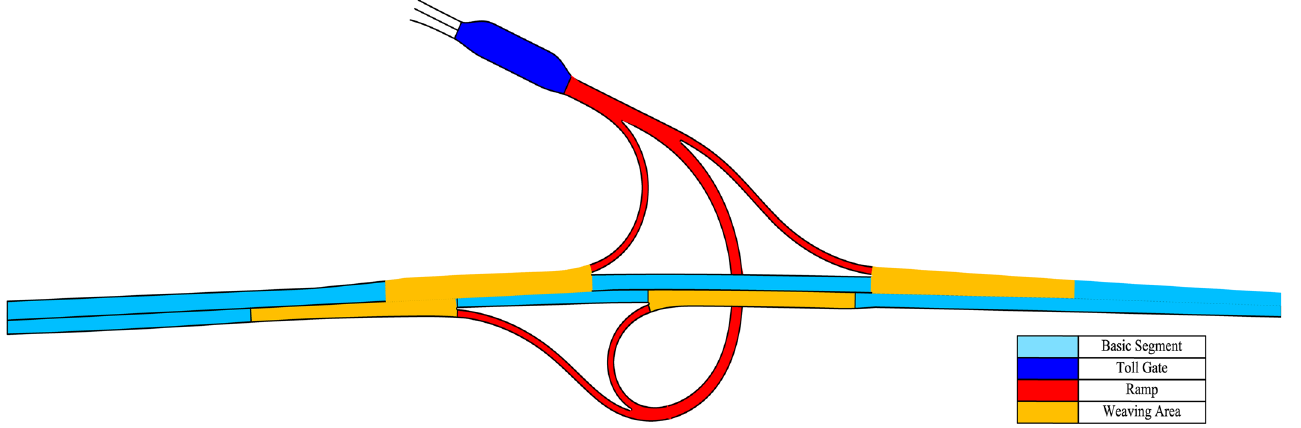
Fig 2. Basic segment, toll gate, ramp, and weaving area around the Toll Gate D.